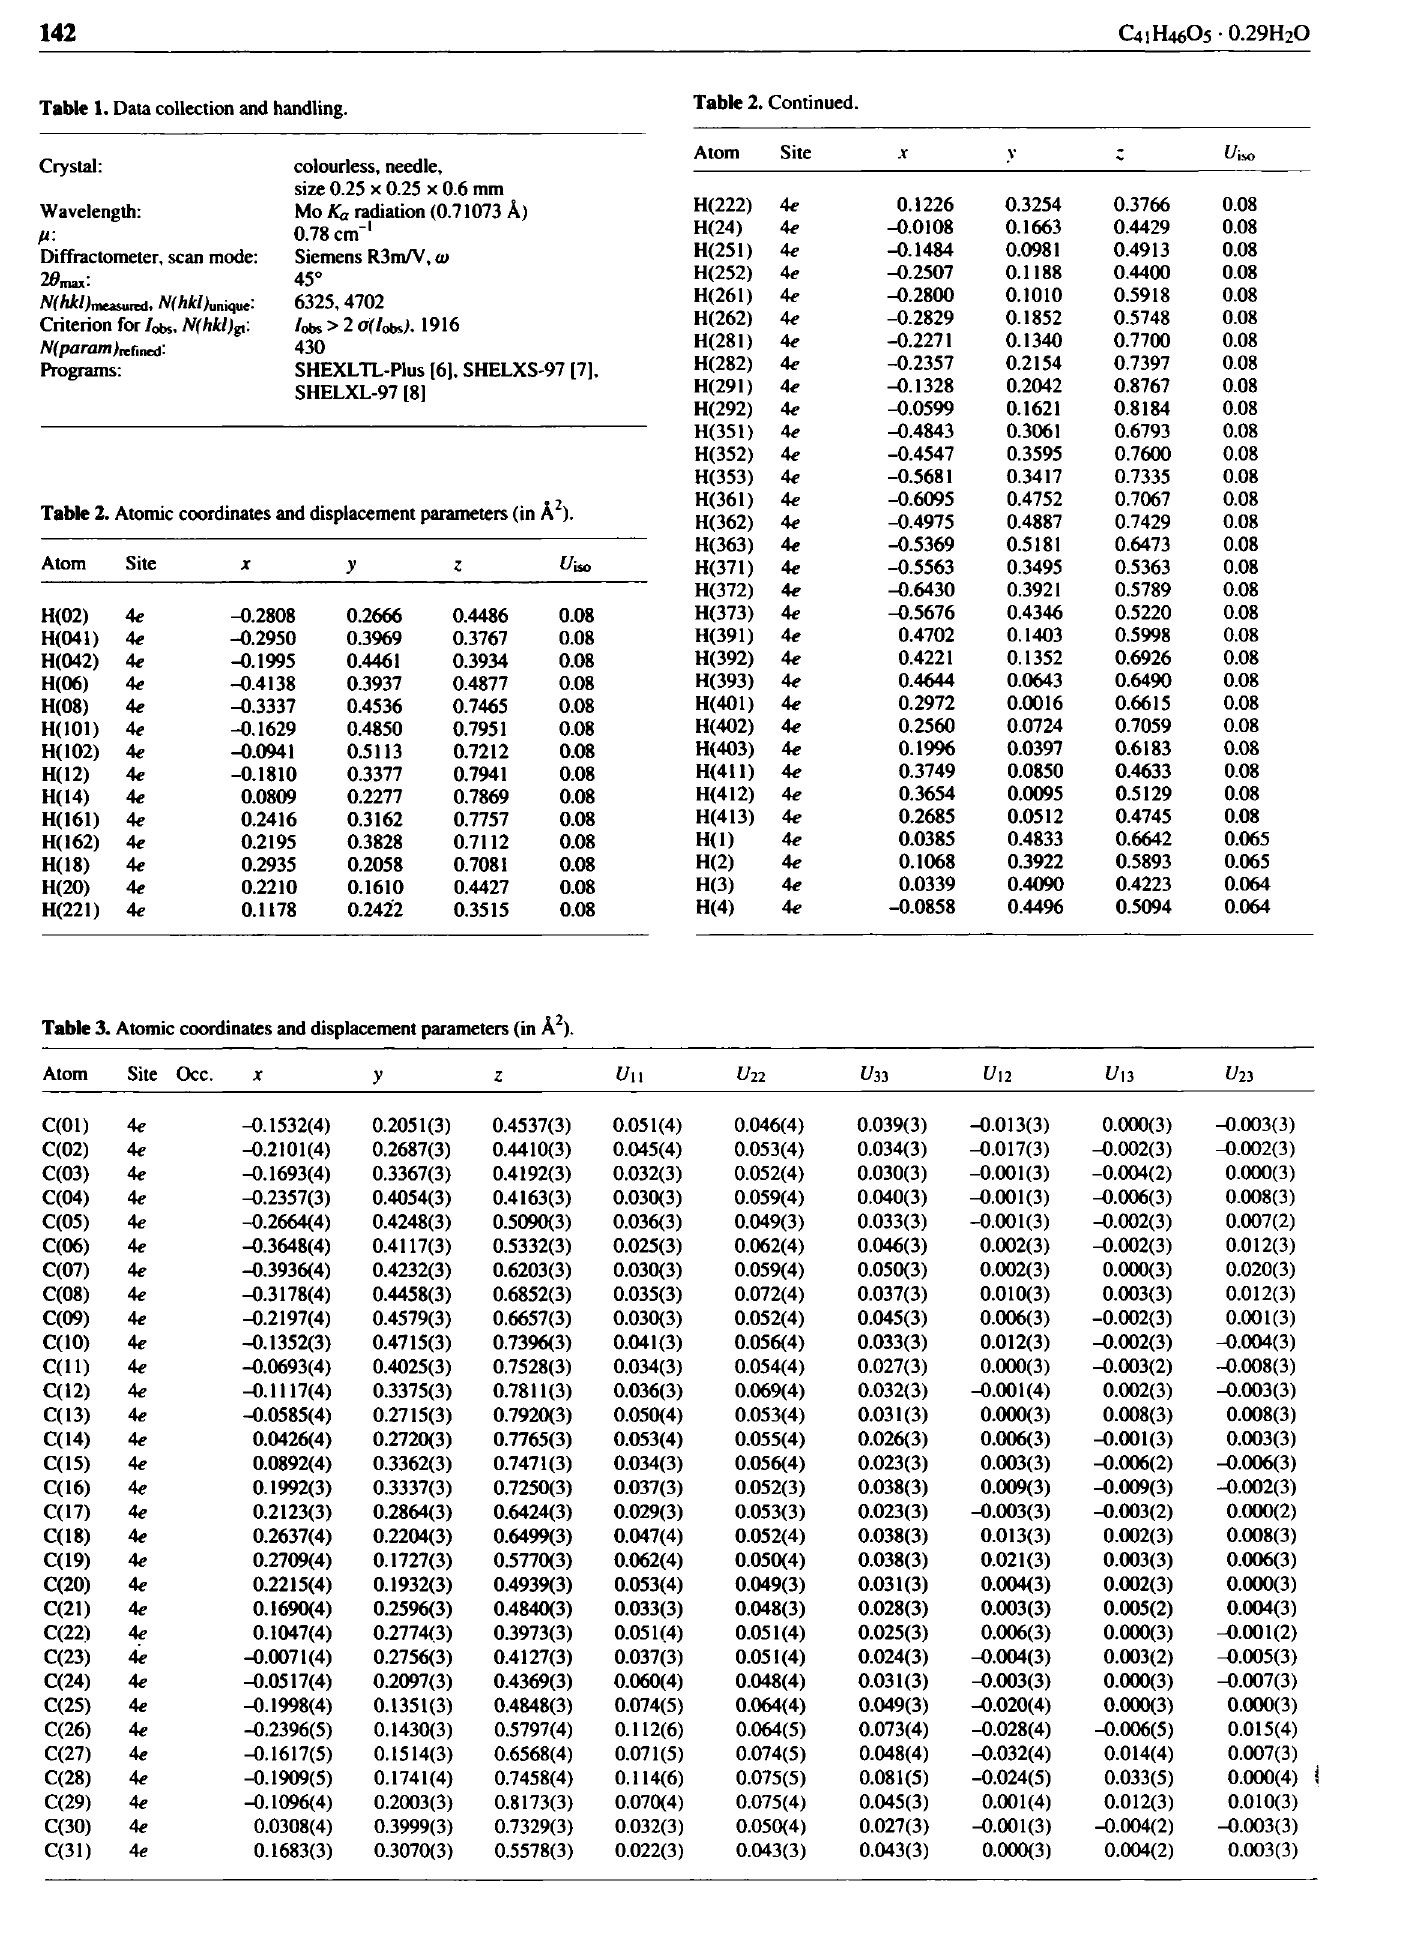
Table 2. Atomic coordinates and displacement parameters (in Â 2 ).